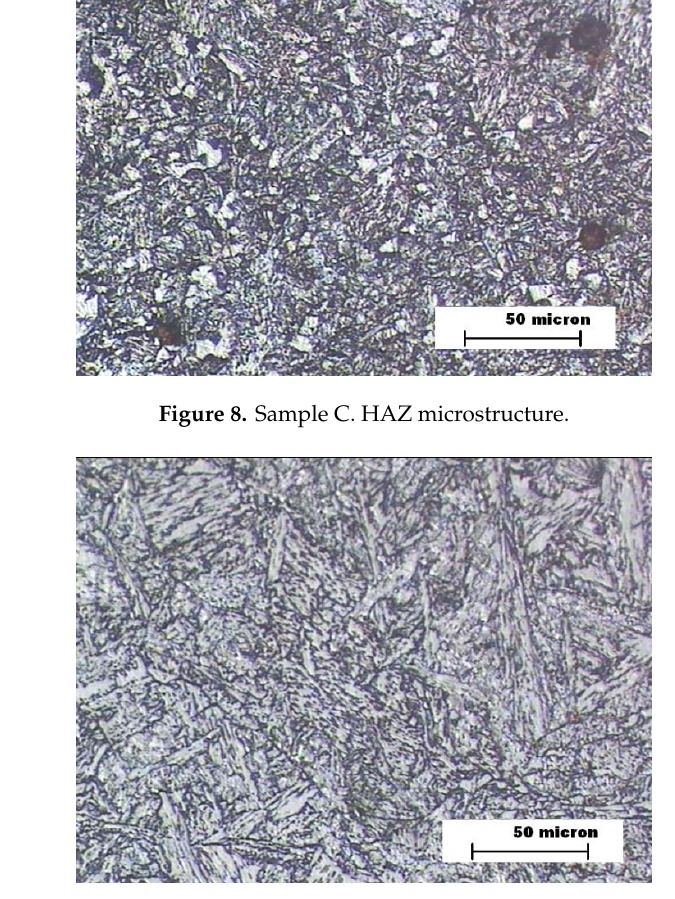
Figure 9. Sample C. FZ microstructure.